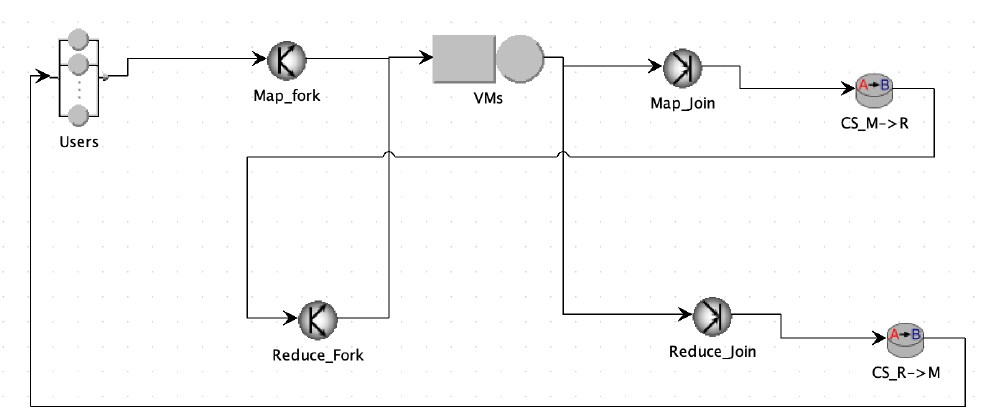
Figure 10. Model of a MapReduce application.